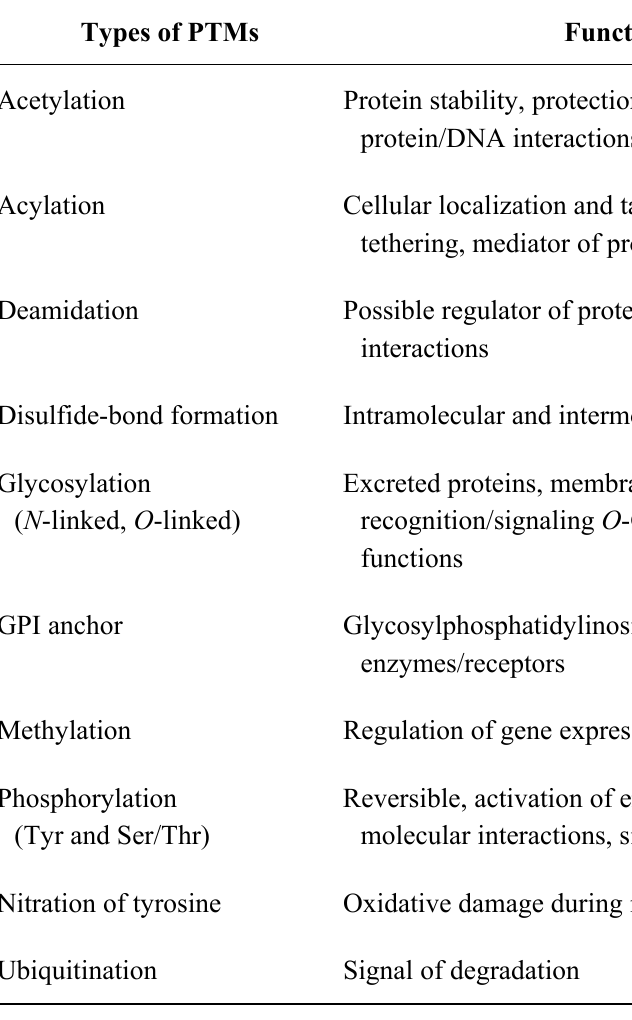
Table 1. Diverse functions of post-translational modifications (PTMs) in cancer and in lung